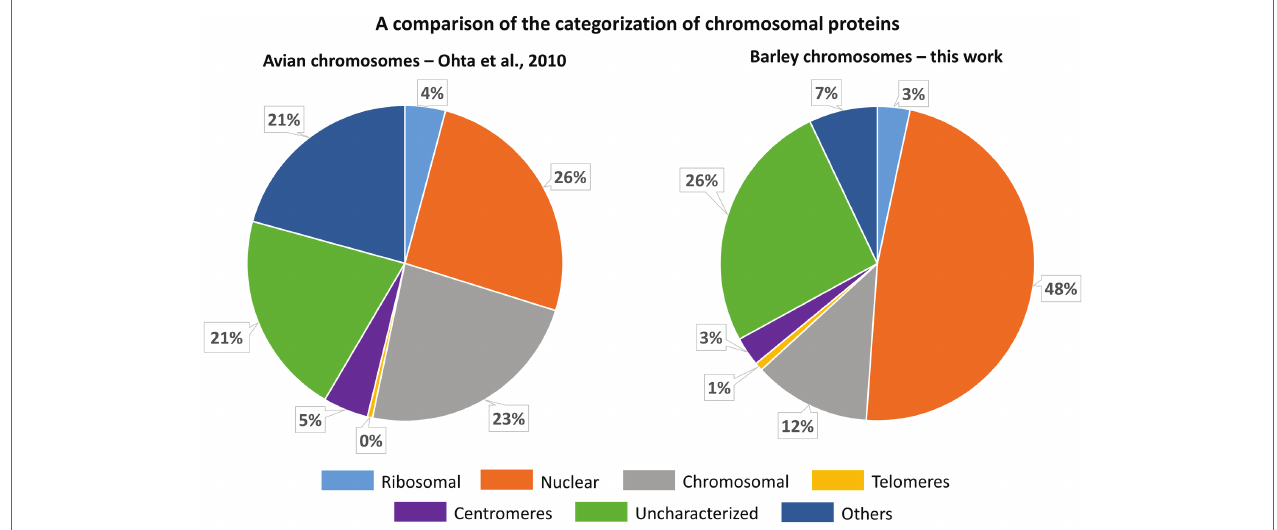
FIGURE 7 | A comparison of the categorization of chromosomal proteins identified for chicken DT40 cells (Ohta et al., 2010) and flow-sorted barley chromosomes (this work). The categorization for barley is derived from information provided in the respective protein names and retrieved by searching in UniProt GO-CC, UniProt Subcellular Localization a DAVID GOTERM-CC data (see Supplementary Table S5